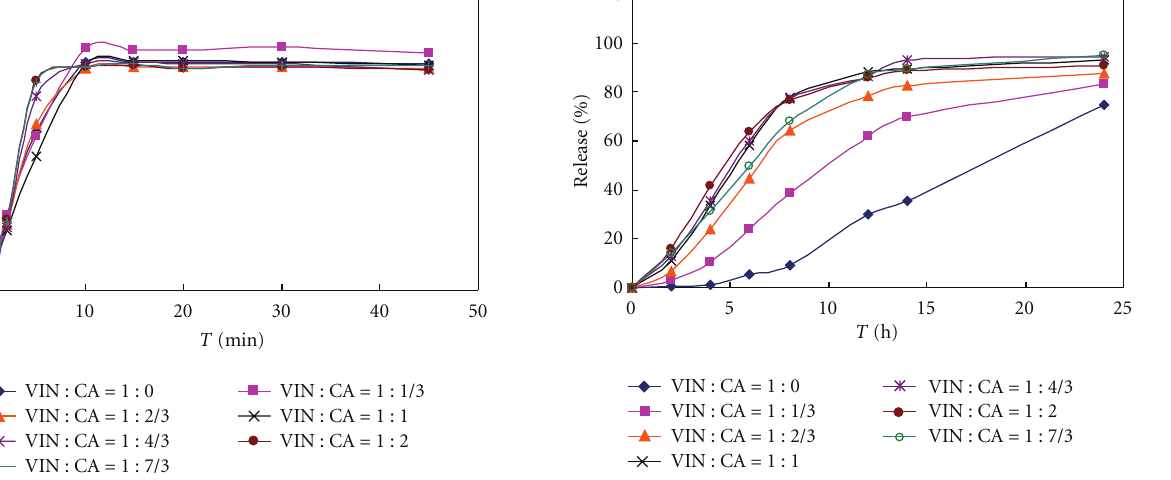
Figure 2: Formulation with di ff erent molar ratio citric acid and vinpocetine dissolution profile (core tablets in 0.1 N HCL